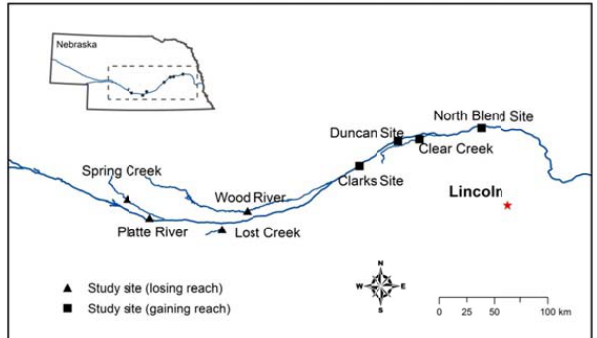
Fig. 1. Location map of eight study sites in south-central and eastern Nebraska. Four study sites were in gaining stream reaches and the other four study sites were in losing stream